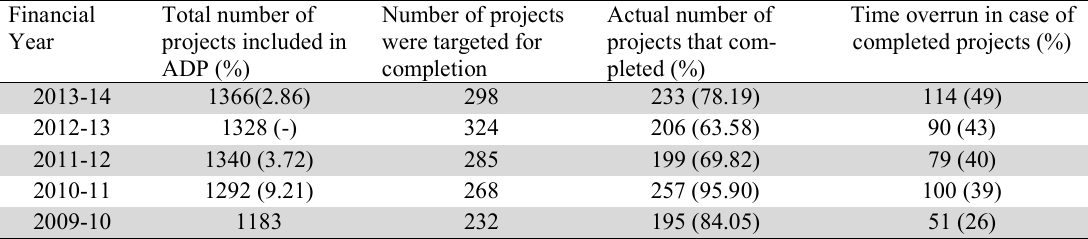
Time overrun in case of completed projects